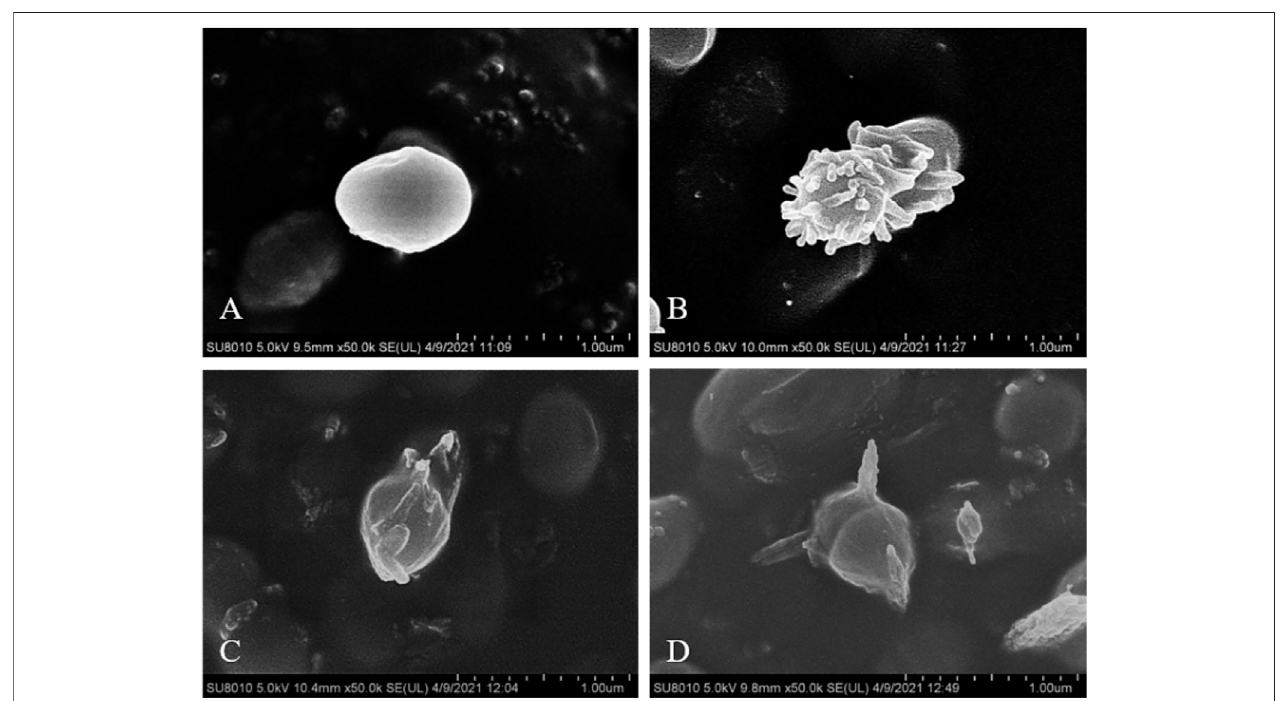
FIGURE3 | SEMobservation of S. aureus ATCC 25923, before (A) and after treatment with1/2 × MICconcentration ofcompounds 21b (B) , 21d (C) and 21f (D) .